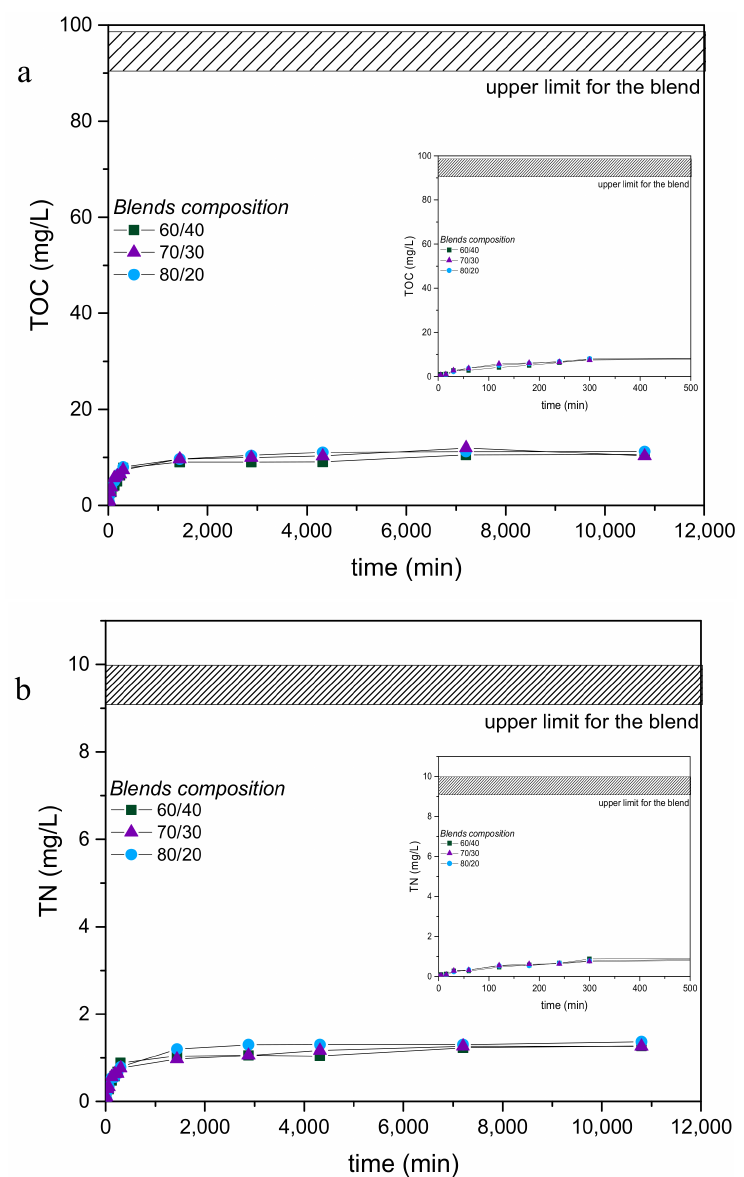
Figure 4. ( a ) Total carbon (TOC) and ( b ) Total nitrogen (TN) results of the 3.5%( w / v ) NaCl solution used for the release study of the coated nets P(VBCTMAM-co-AA20) / P(DMAm-co-GMA30) 60 / 40, 70 / 30, 80 / 20 w / w for seven